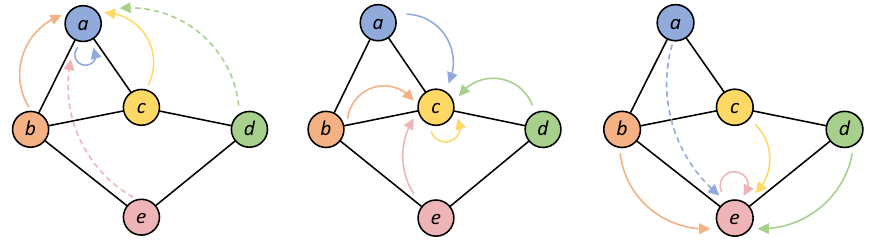
Figure 3. Convolution operation of node a, c, e in